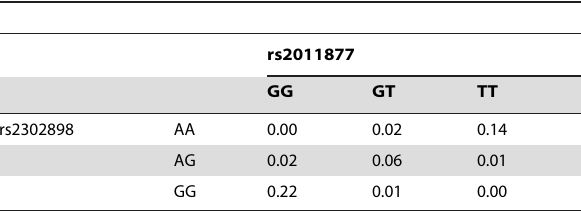
Table 2. Frequency of red hair phenotype as a function of genotype of two non-causal SNPs tagging the causal variants at the MC1R gene